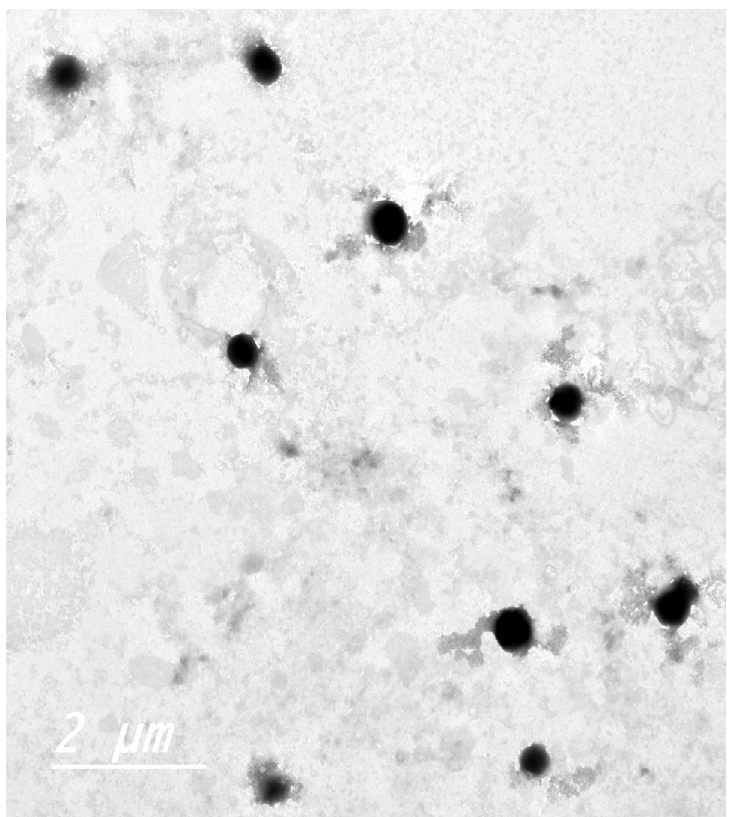
Fig 2. TEM micrograph of the optimized DAC-loaded